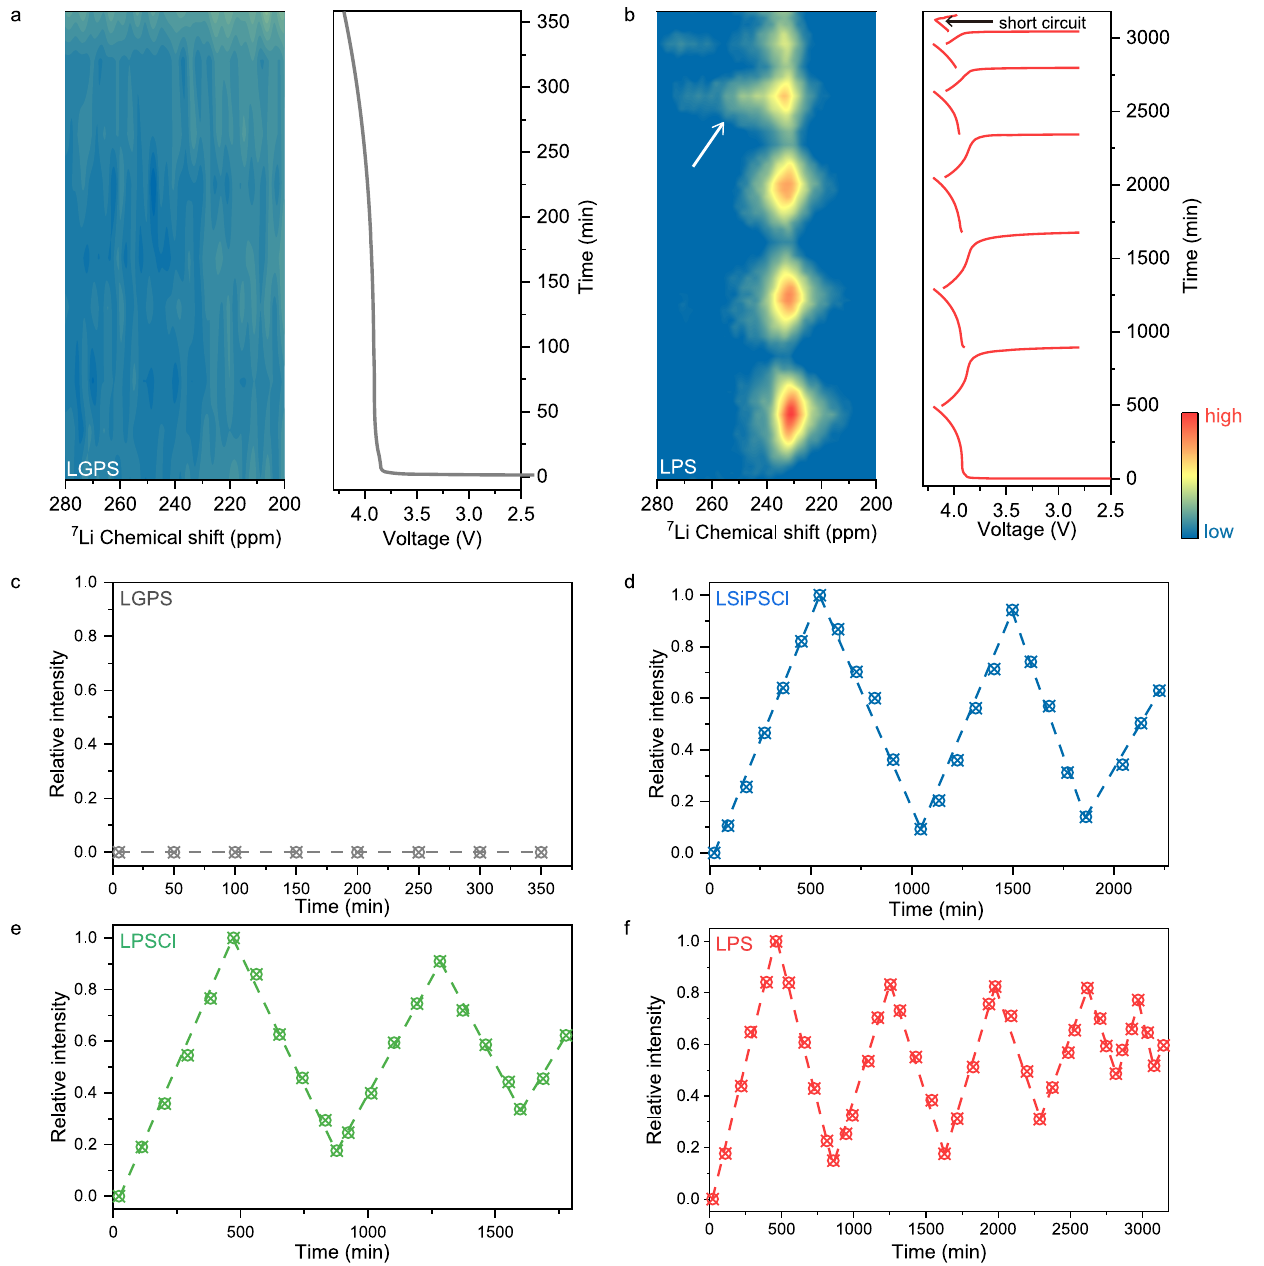
Fig. 3 | Contour plots of operando 7 Li NMR spectra and their corresponding charge/discharge curves of AFBswithtwo different SSEs.a , b LGPS ( a ), LPS ( b ). The integral of the lithium metal signal versus time, c – f , for LGPS ( c ), LSiPSCl ( d ),